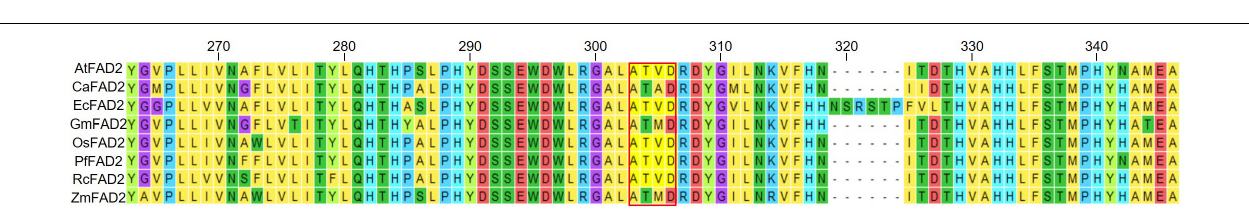
(A295G; D298E) and fad2-321 (A295V; T296M).